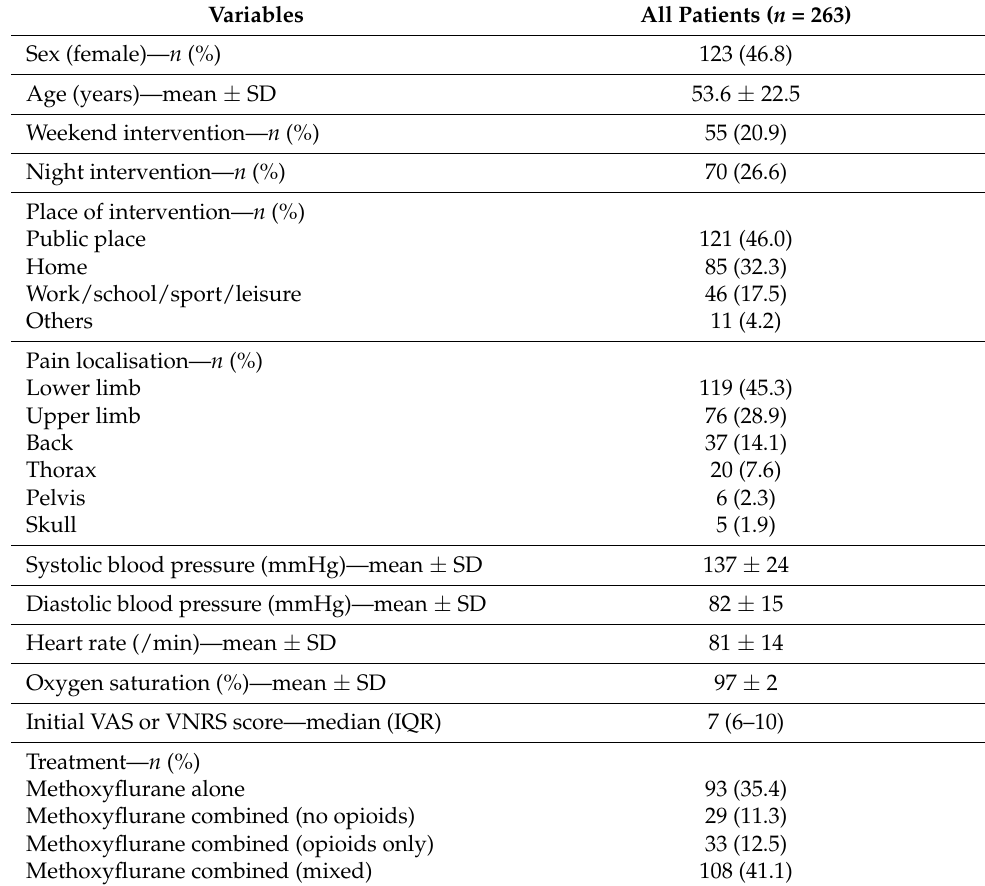
Table 1. Patients characteristics.